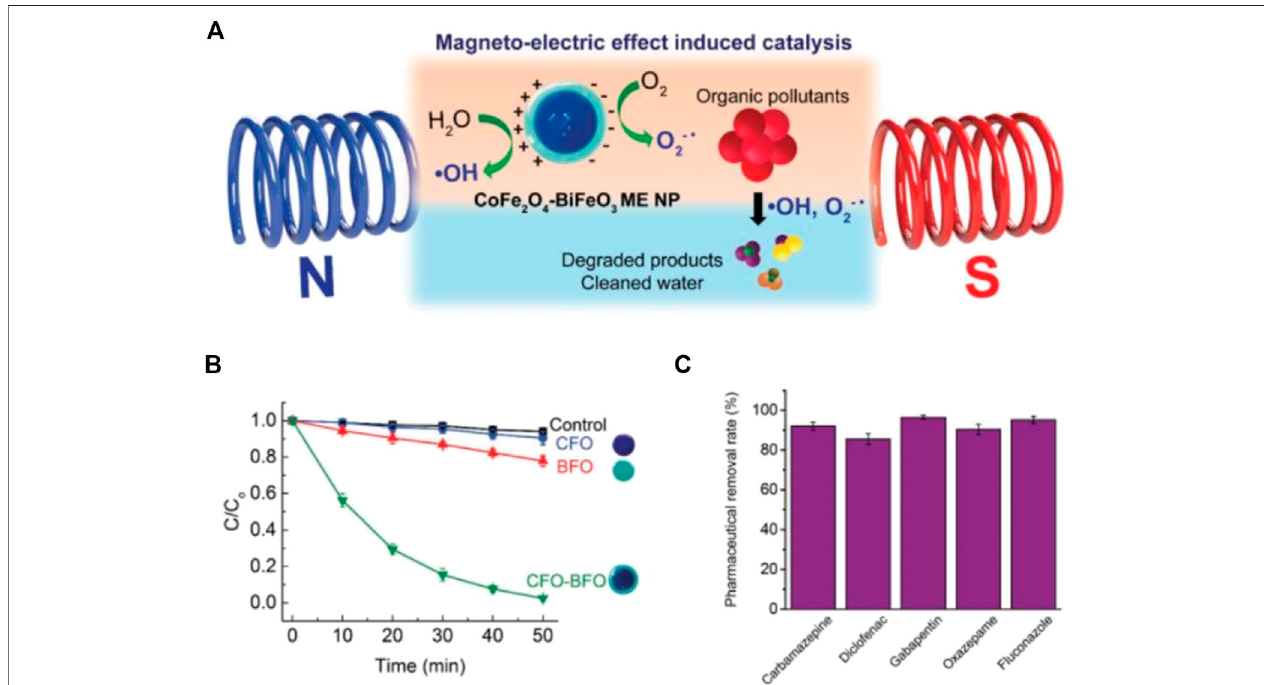
FIGURE 5 | (A) Scheme showing magnetoelectric (ME) effect induced catalytic degradation of organic pollutants using core – shell CFO – BFO NPs under magnetic fi elds (B) Catalytic degradation curves obtained for model organic dye, RhB, under 15 mT and 1 kHz magnetic fi elds ( n (cid:2) 5) (C) Removal ef fi ciency of a cocktail of fi ve common pharmaceuticals using the core – shell NPs ( n (cid:2) 4). Copyright 2019, John Wiley and Sons (Mushtaq et al., 2019).